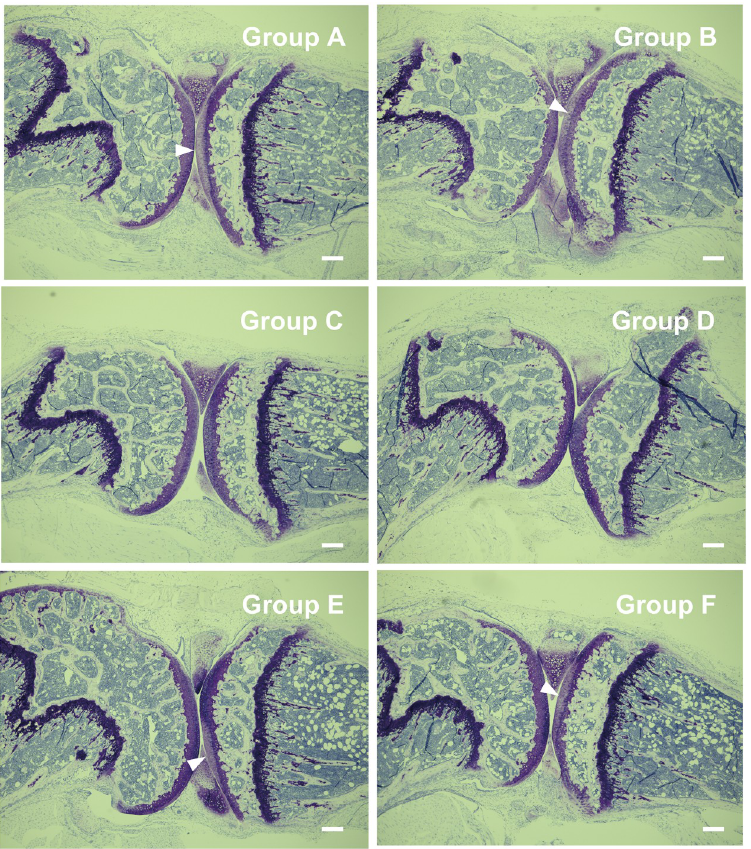
Fig 3. Toluidine blue staining of the knee joints of mice treated with MIA. Knee joints were excised from mice belonging to group A, B, C, D, E and F on day 21 and processed according to the methods described under Materials and methods. Original magnification was x40. Bars indicate 200 μ m. Damage of cartilage was observed in group A, B, E and F (indicated by arrowheads). (SLIGKV-NH ) instead of BMMCs injected into the OA knee joints on day 14 significantly 2 enhanced pain (Fig 7, group F).